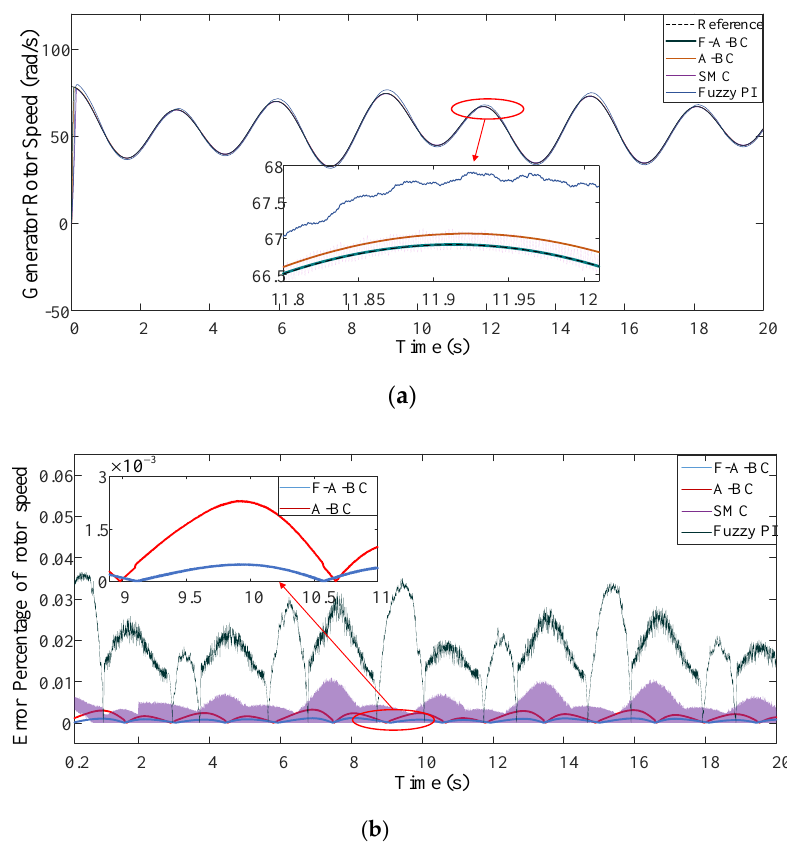
Figure 5. The rotor speed and rotor speed error responses under swell effect. ( a ) The rotor speed under swell effect; ( b ) the error percentage of rotor speed under swell effect.